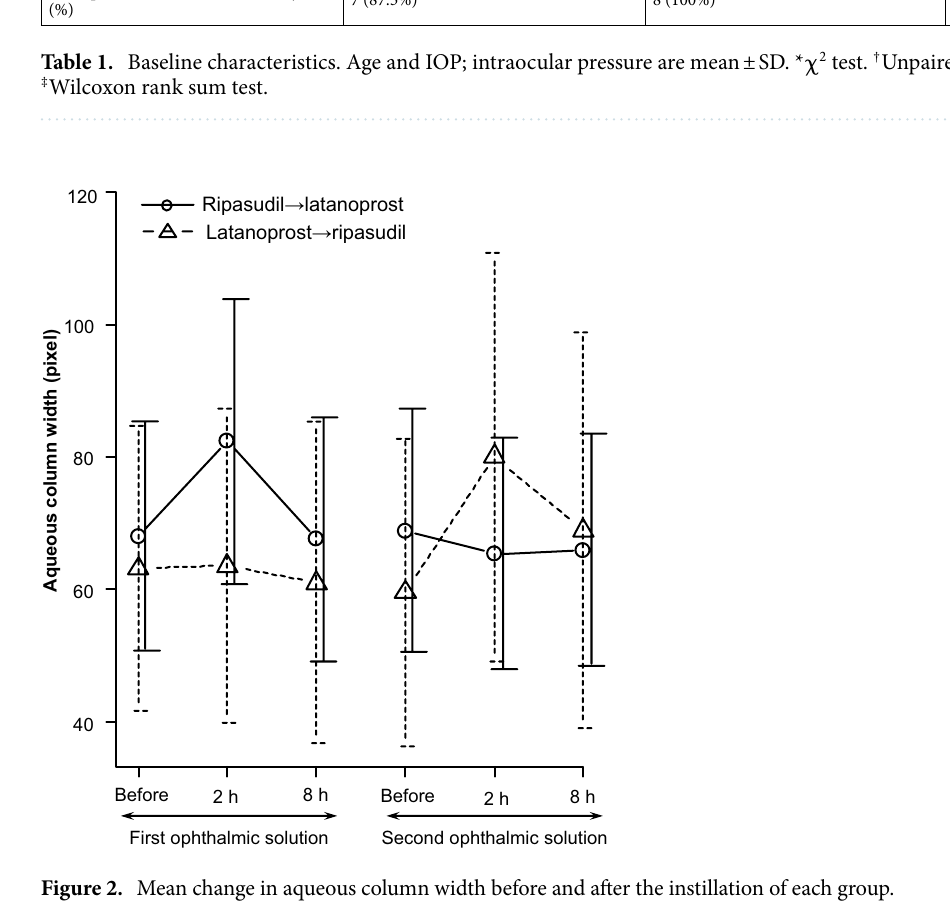
Figure 2. Mean change in aqueous column width before and after the instillation of each group.